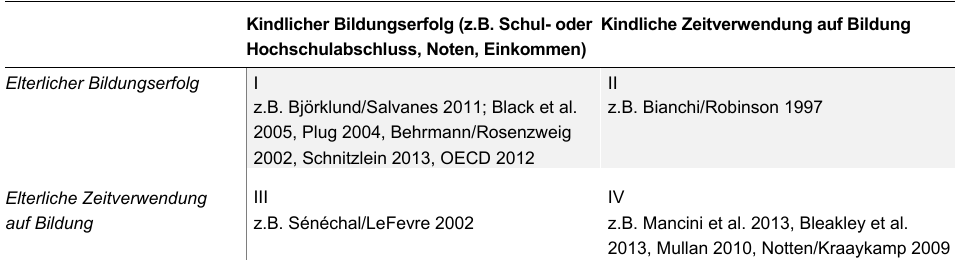
Tabelle 1 : Eltern-Kind-Bezüge zwischen Bildungserfolg bzw. -verhalten